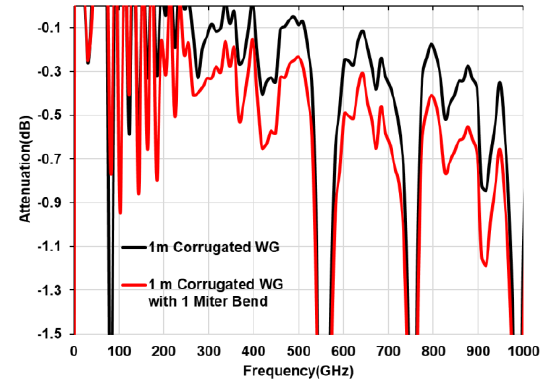
Fig. 6: Measured attenuation for circular corrugated Waveguide sections